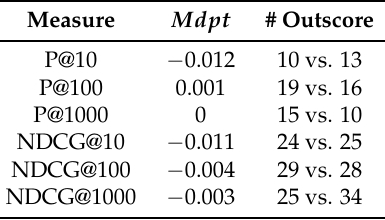
Table 24. T1: comparison of the best run vs. the CombSUM fusion of the two best runs.